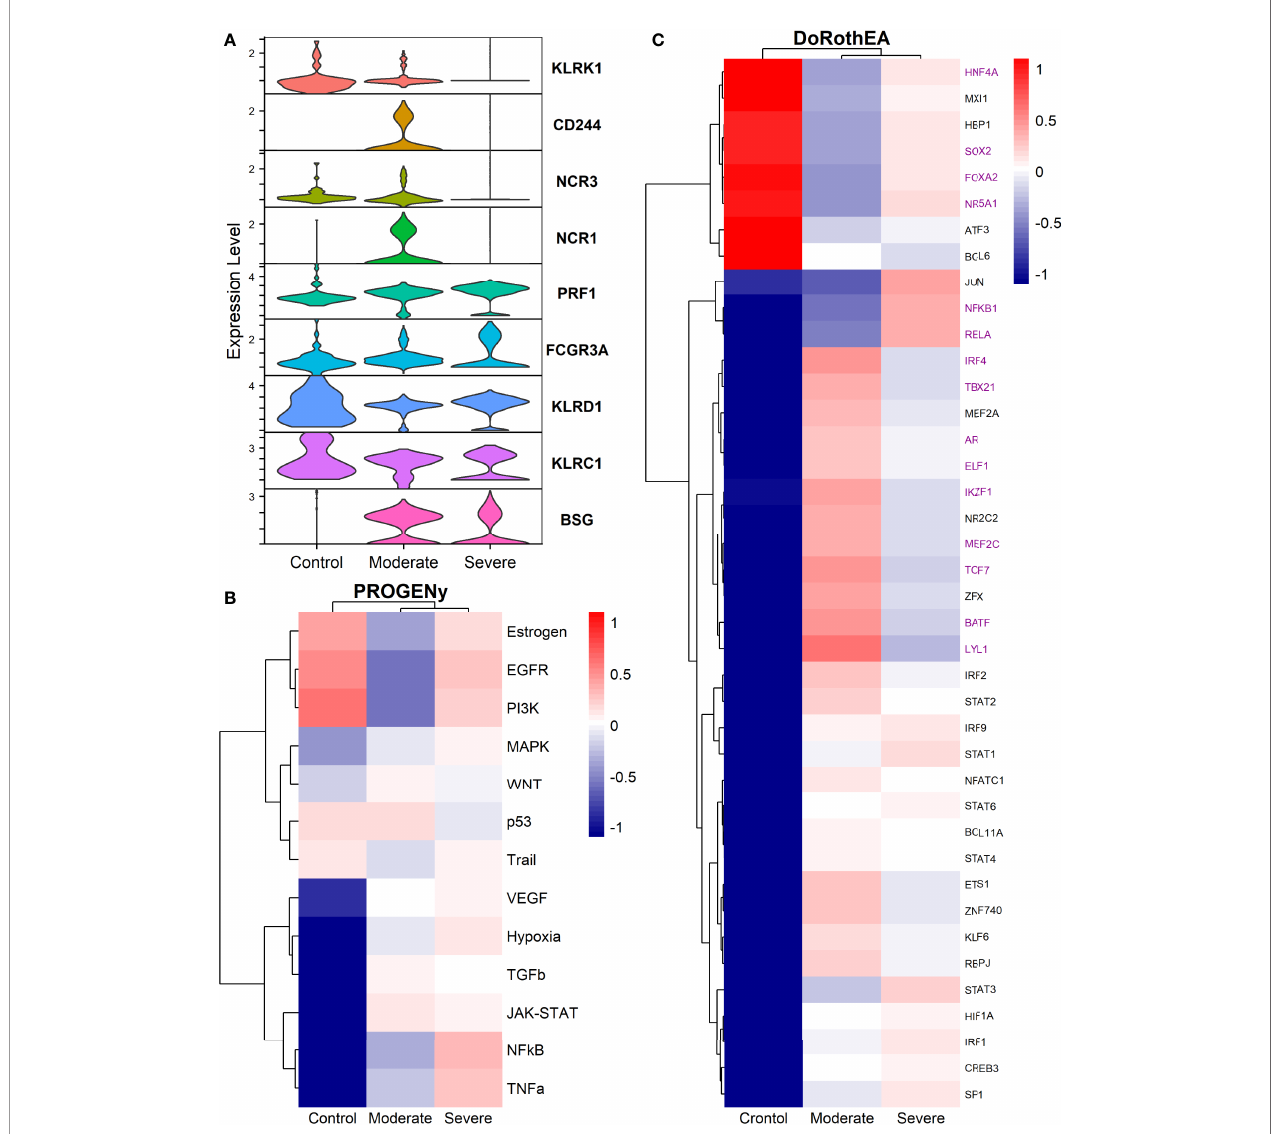
FIGURE 7 | TFs associated with the disease severity in NK cells. (A) Violin plots for several markers for the healthy controls, moderate and severe patients. (B) Resulting Heatmap from PROGENy analysis. Colorbar sets the activation (red) and inactivation (blue) values. (C) Resulting Heatmap from DoROthEA